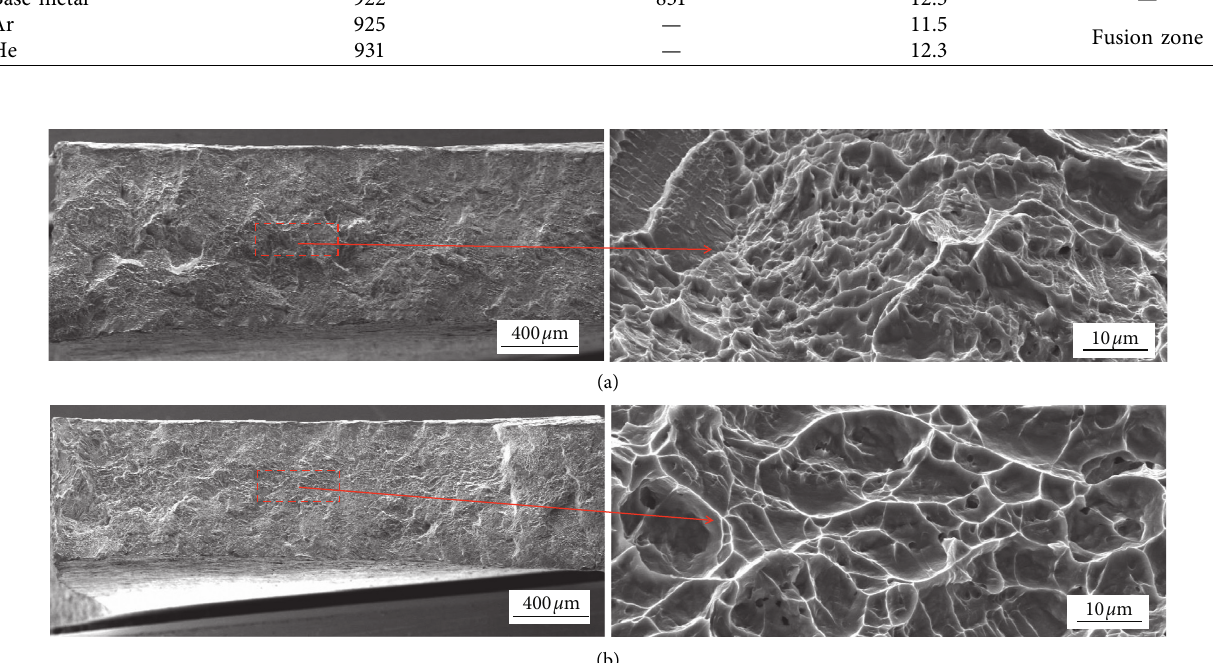
Figure 9: Fracture morphology of tensile fracture with different shielding gases: (a) Ar; (b)